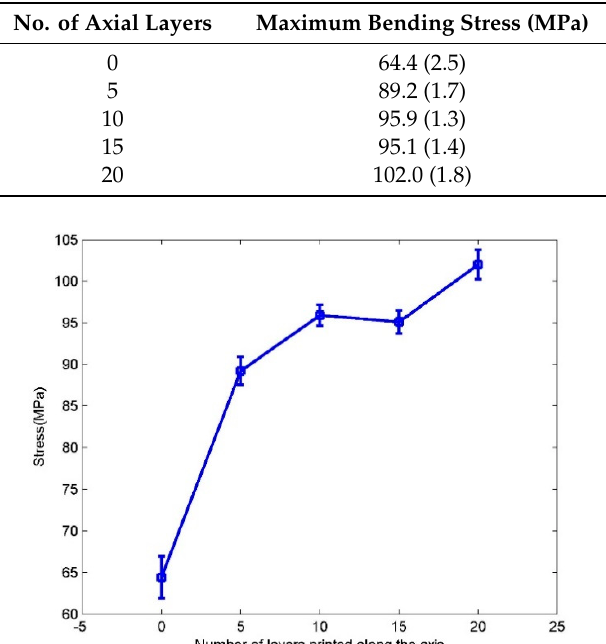
Table 3. Three-point bending tests the maximum stress of each group.